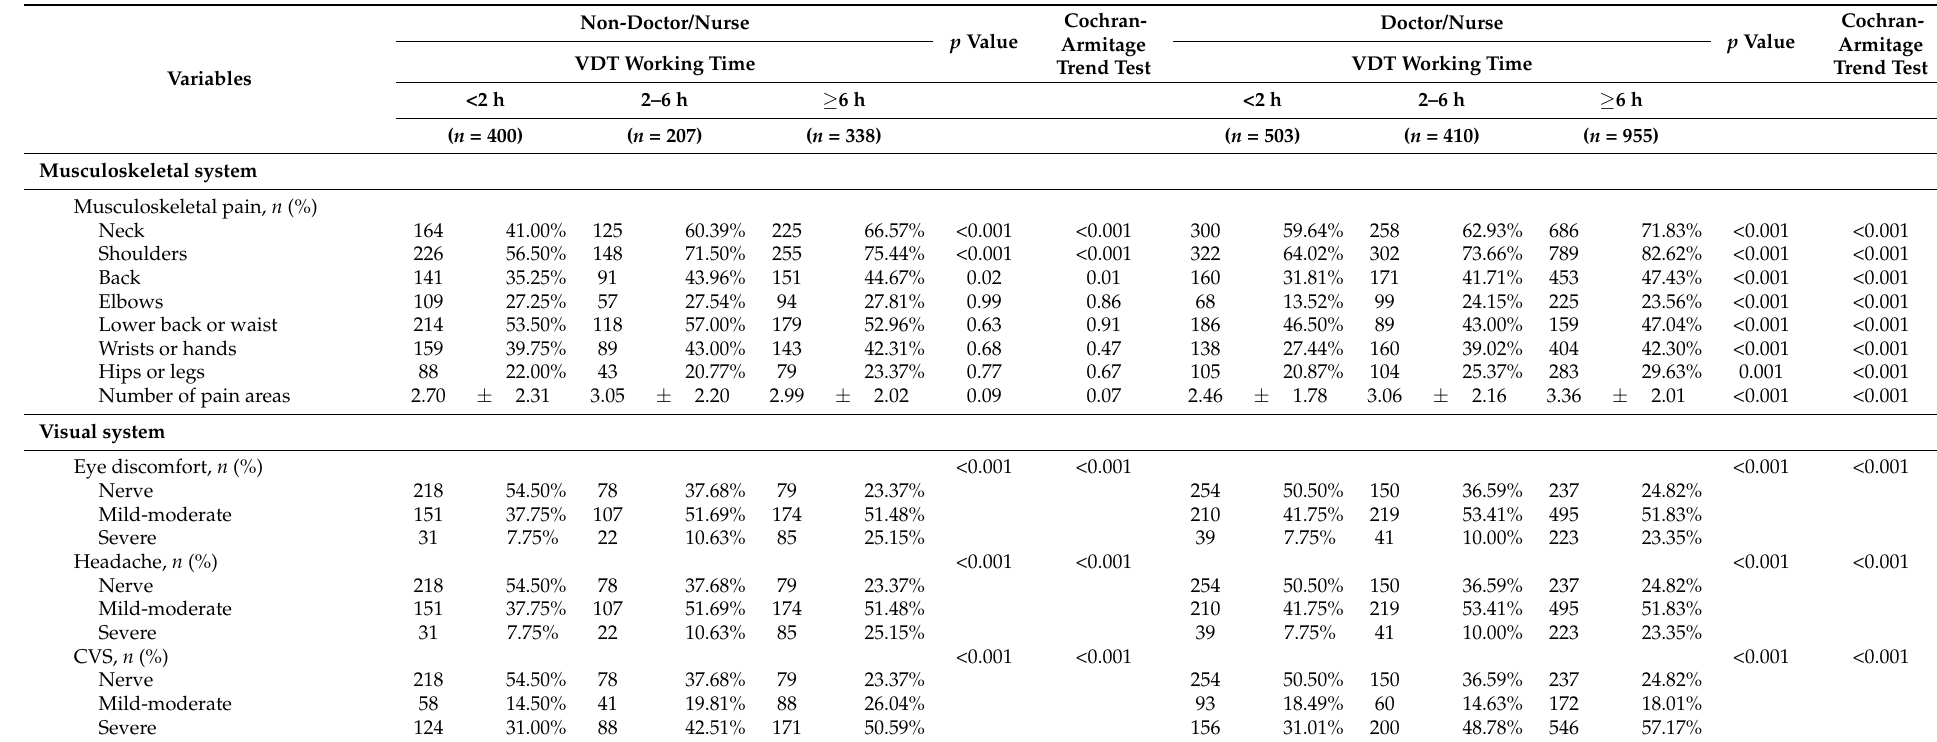
Table 2. Prevalence of physical health conditions among different durations of daily VDT working hours in hospital